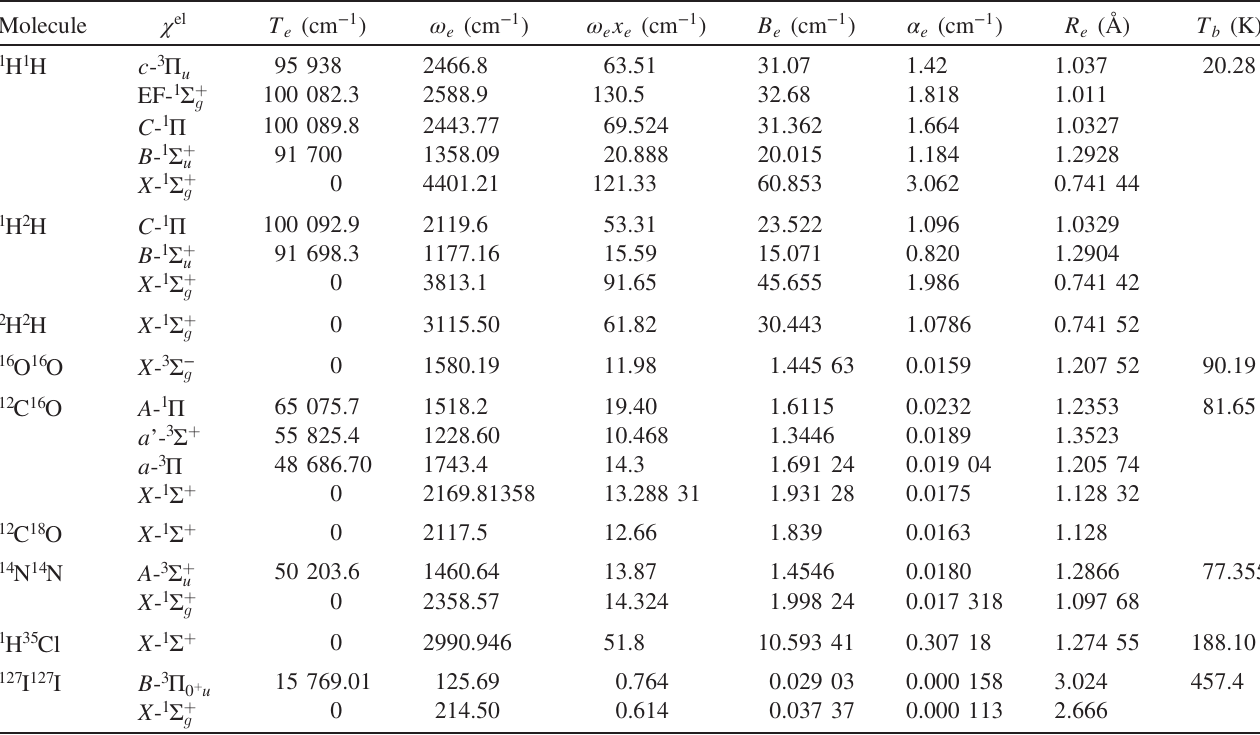
TABLE I. Spectroscopic properties of select diatomic molecules in the ground electronic state χ el ¼ X, as well as in a few exemplary excited electronic states χ el ¼ A; a; B; b; … taken from Ref. [14]. Energetic quantities such as the electronic excitation energy T x vibrational energy splitting ω and anharmonic correction ω , rotational constant B , and vibration-rotation correction constant α e e e e expressed in the conventional inverse photon-equivalent-wavelength units of cm − 1 ; conversion to units of energy is achieved via the and boiling-point temperature T substitution 1 cm − 1 ↔ 1 . 239 67 × 10 − 4 eV. We also quote the equilibrium radius R e states) at standard atmospheric pressure P ¼ 1 bar.